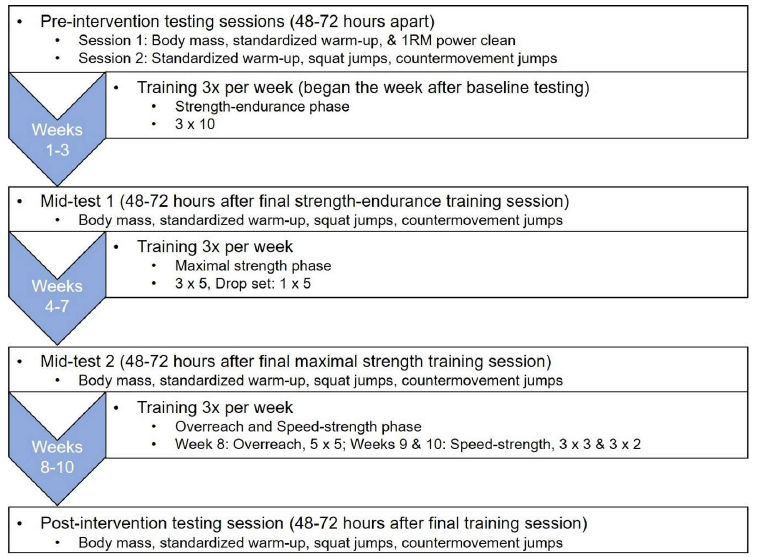
Figure 1. Testing and training sequence. Sets × repetitions.